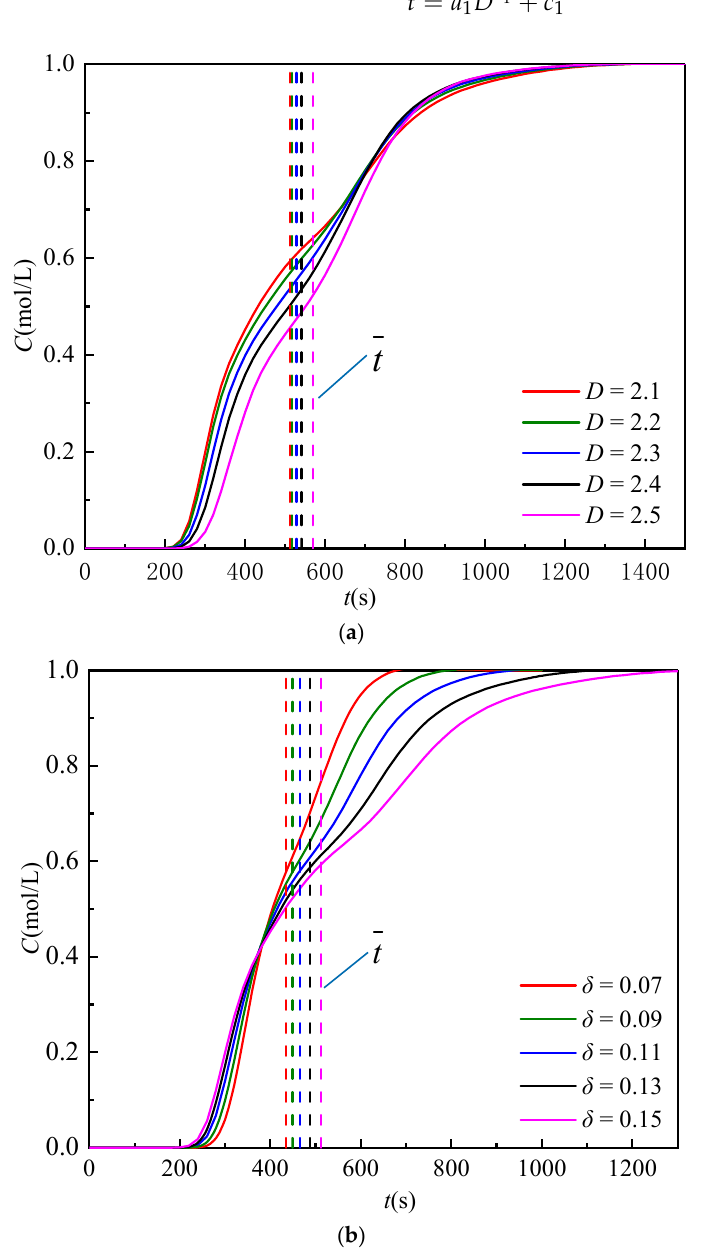
Figure 6. The breakthrough curves from ( a ) different D and ( b ) different δ conditions. As shown in Figure 7b, the average time increases linearly with the increase of the standard deviation of aperture. The relationship between the average time and standard deviation of aperture is described by: